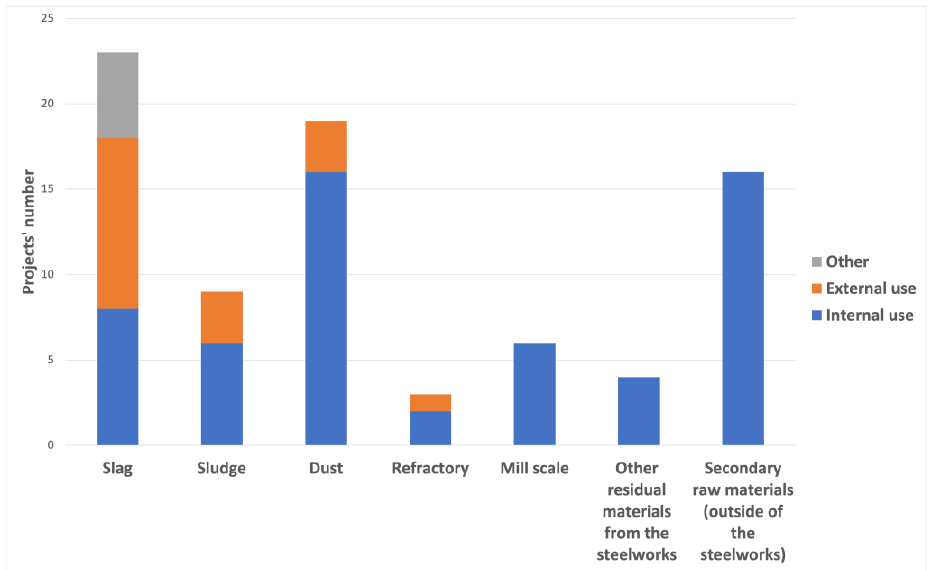
Figure 7. By-products based on type of use/recycling [54].